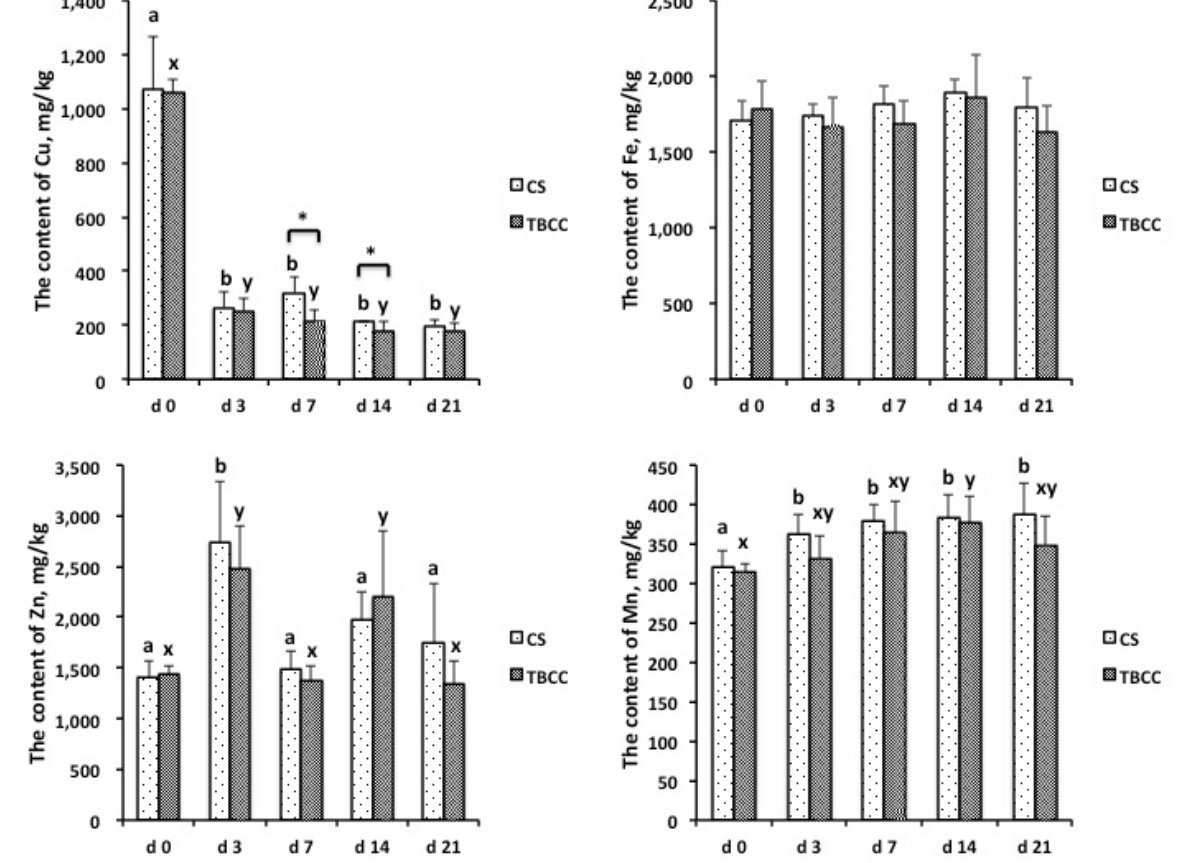
Figure 2. The concentrations of Cu, Fe, Zn, and Mn in feces of pigs when the supplementation Cu level changed from 130 mg/kg to 10 mg/kg with the copper sulfate (CS) or tribasic copper chloride (TBCC) diet at d 0, 3, 7, 14, and 21 (mg/kg dry matter). Means with different superscript letters represent differences between different time points within the CS diet ( a–c ) or the TBCC diet ( x–z ; p<0.05). * p<0.05, CS vs TBCC.